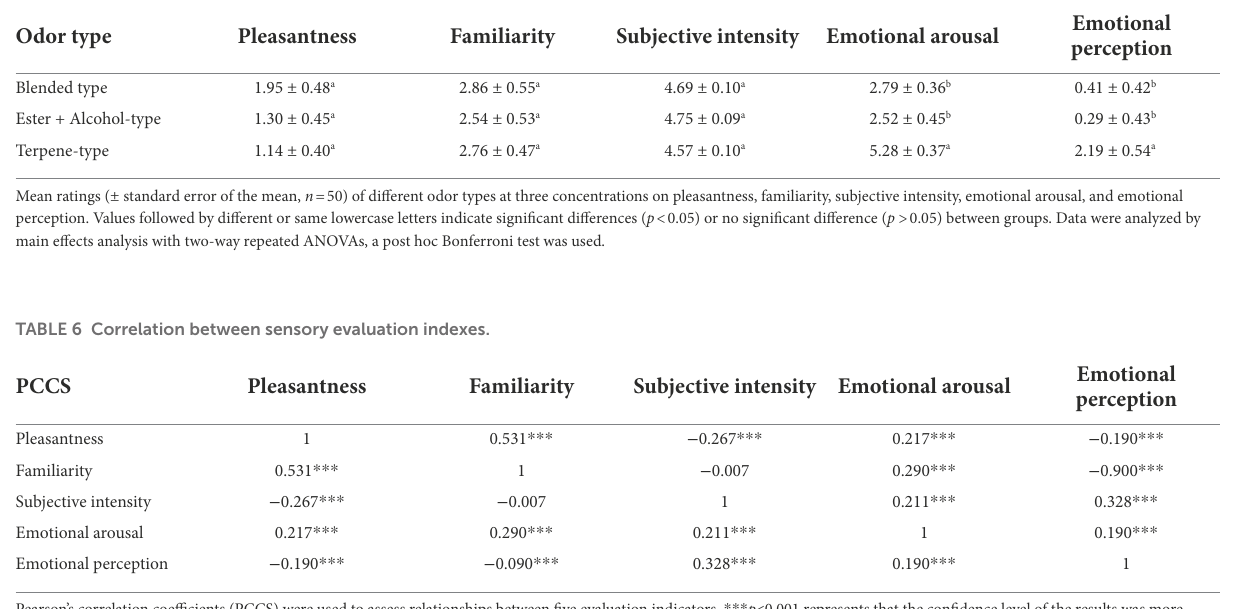
TABLE 5 Sensory evaluation of different odor types.